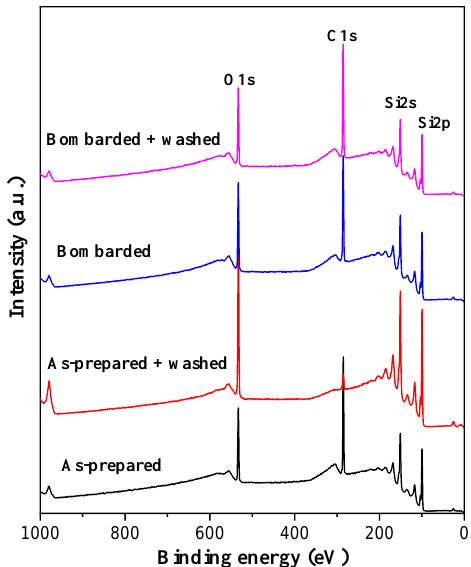
Figure 3. Comparisons of XPS survey spectra of C 32 H 66 thin film prepared at the concentration of 0.3% w/v after different surface treatments.